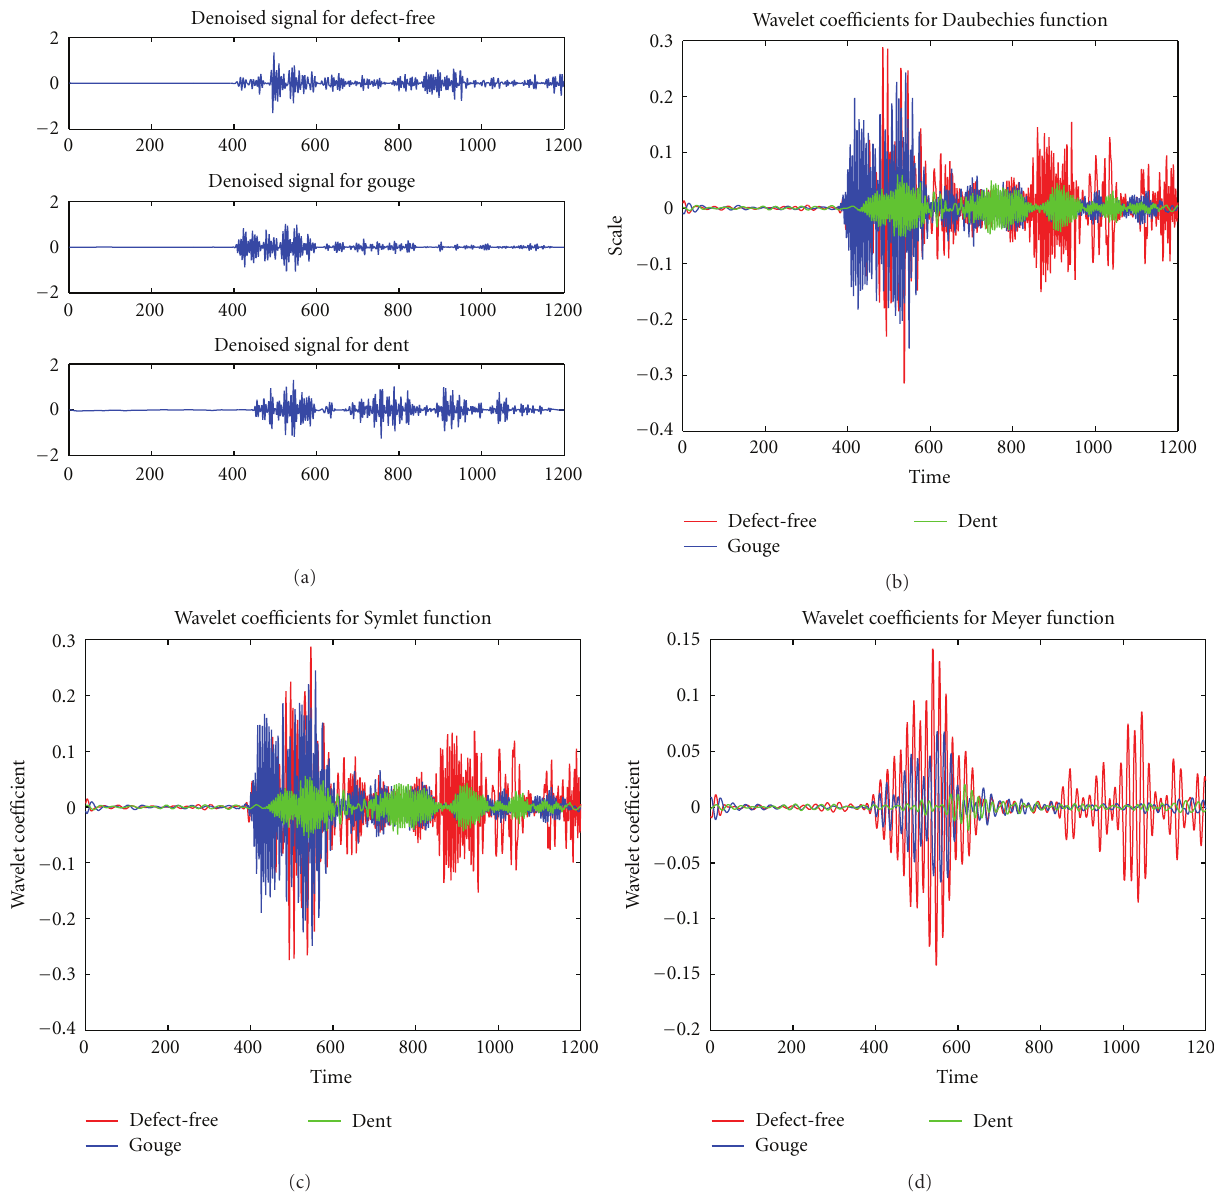
Figure 10: (a) denoised signals for defect-free, gouged, and dent pipes. Continuous wavelet transforms for defect-free, gouged, and dented pipes when pipes are embedded in soil, (b) for Daubechies (db4) function, (c) for Symlet (sym4) function, (d) for Meyer function.